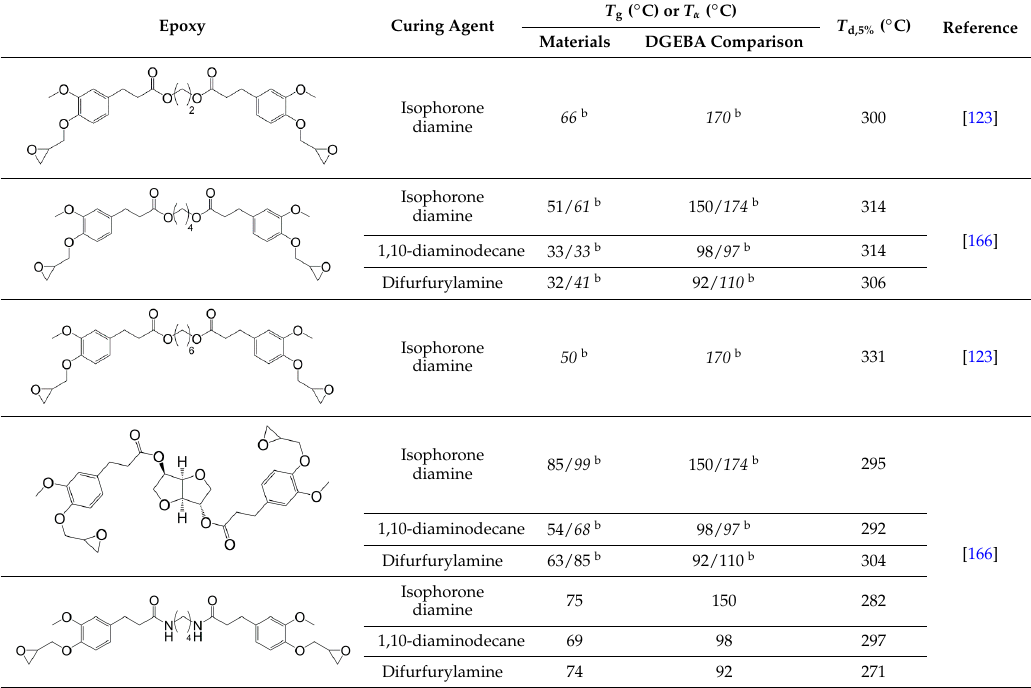
Table 5. Di-epoxy monomers with two aromatic rings separated by more than one atom, and thermal properties of the cured materials. Epoxy